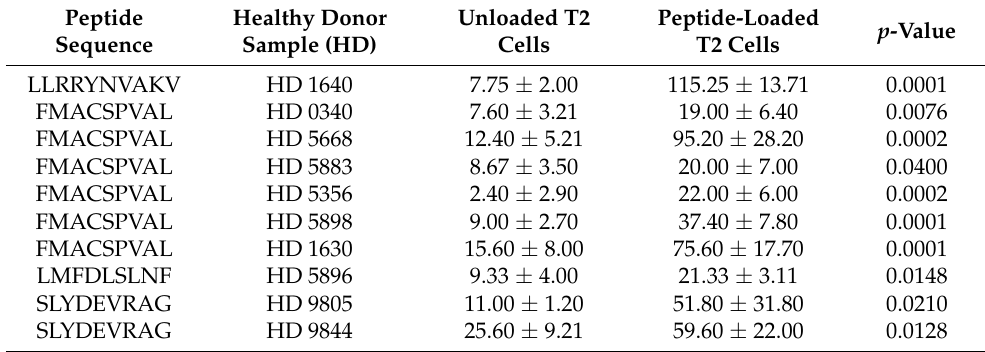
Table 3. Summary of peptide-specific T cell responses from different healthy donors.